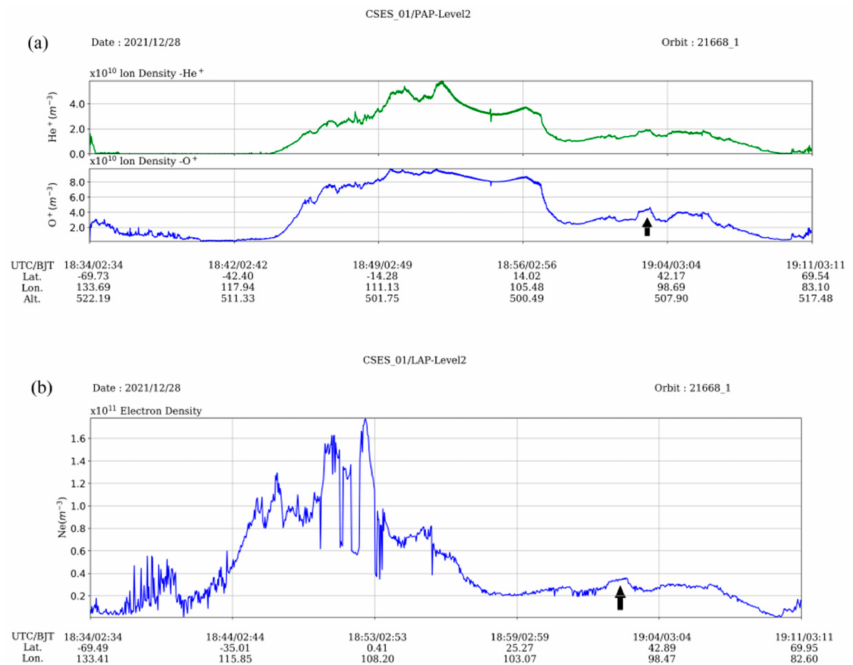
Figure 10. Fluctuations in ( a ) He + and O + densities and ( b ) electron density registered by the CSES satellite on 28 December 2021, 11 days before the Menyuan M S 6.9 EQ. Obvious perturbations related to this Menyuan event are labeled with black